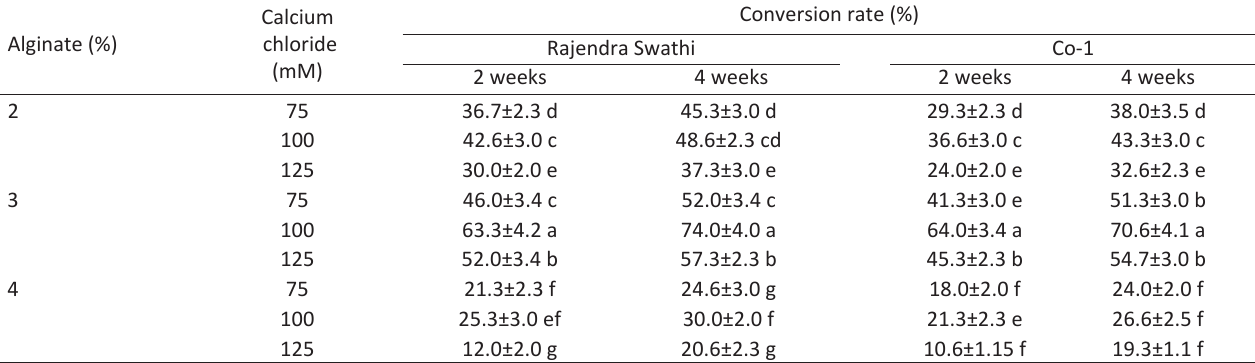
Values are expressed as mean standard deviation, mean values within a column followed by different letters are significantly different (at p= 0.05) according Duncan’s multiple